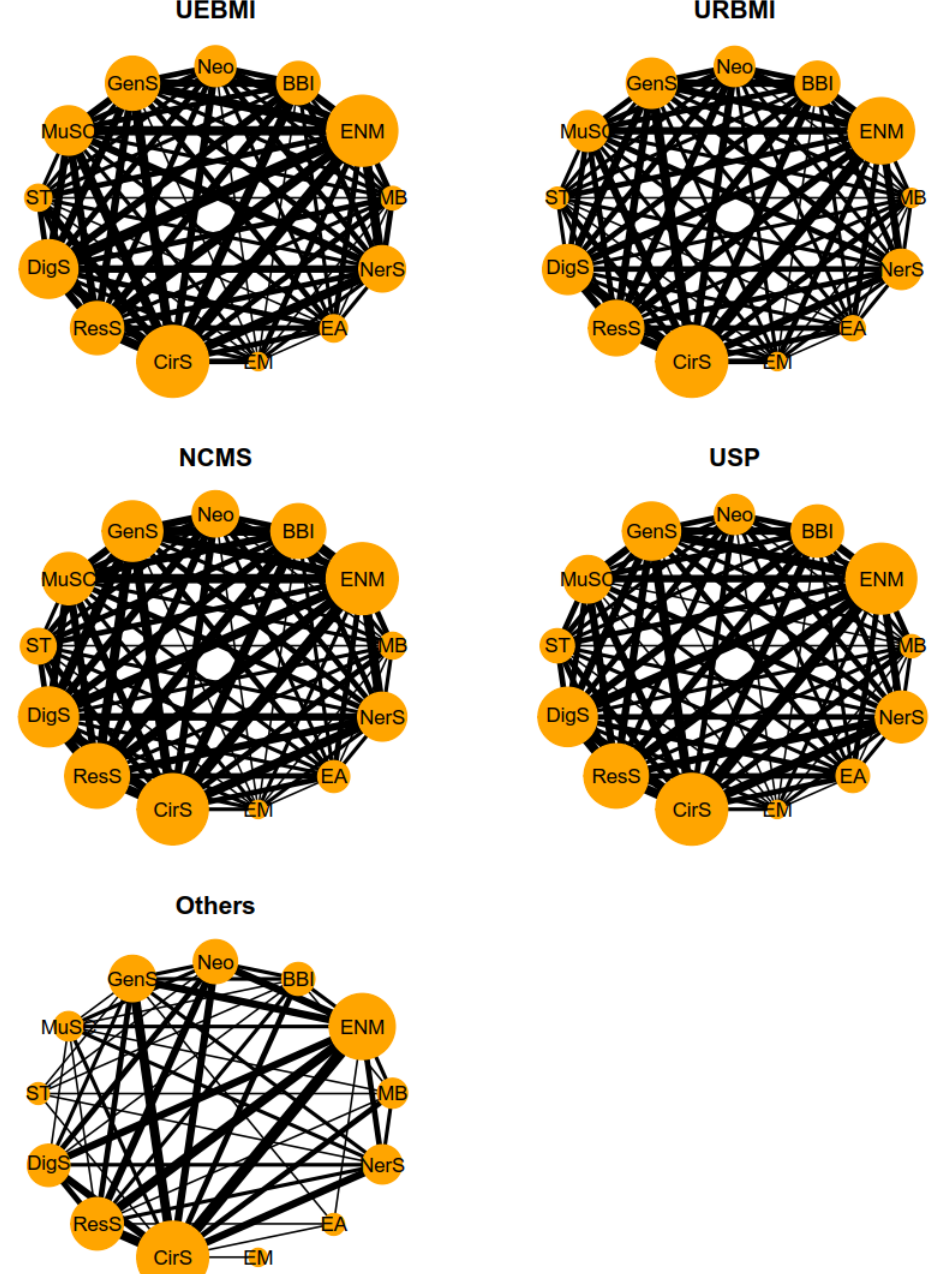
Figure 5. Multimorbidity networks by health insurance schemes for 13 systemic diseases.